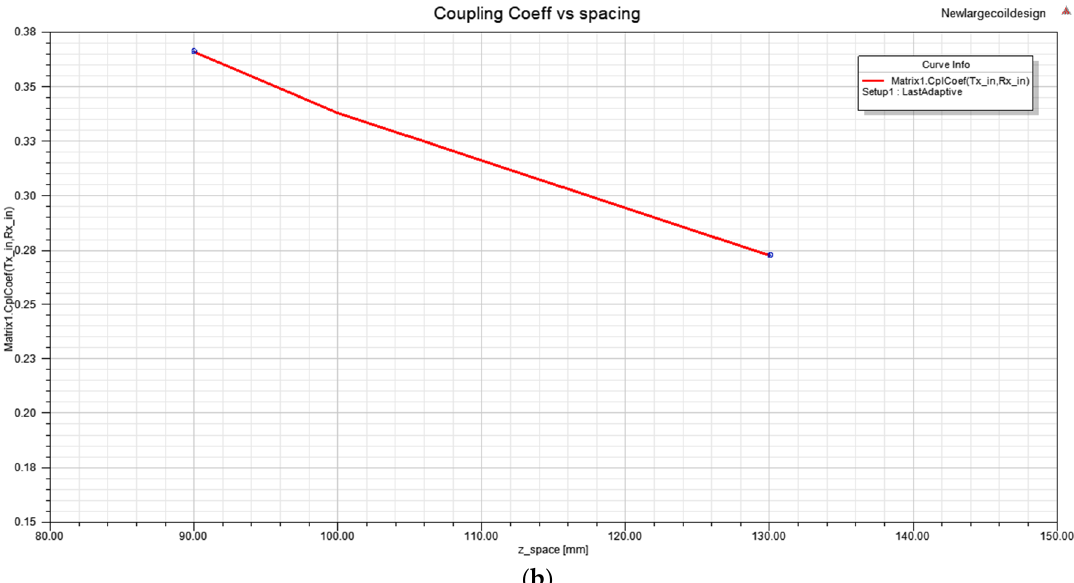
Figure 10. Results for 600 mm spiral coil excited at 8 A: ( a ) Mutual inductance vs. air gap spacing (mm). ( b ) Coupling coefficient vs. air gap spacing (mm).